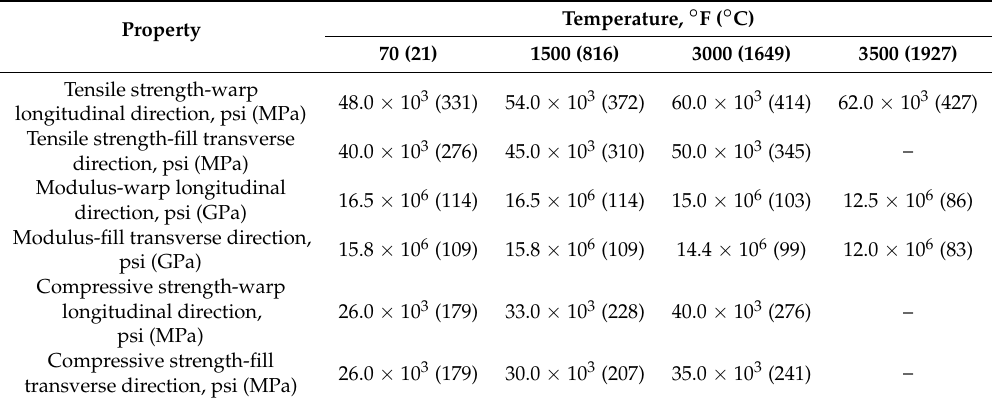
Table 1. Mechanical properties of a typical unidirectional carbon/carbon (C/C) composite at various temperatures